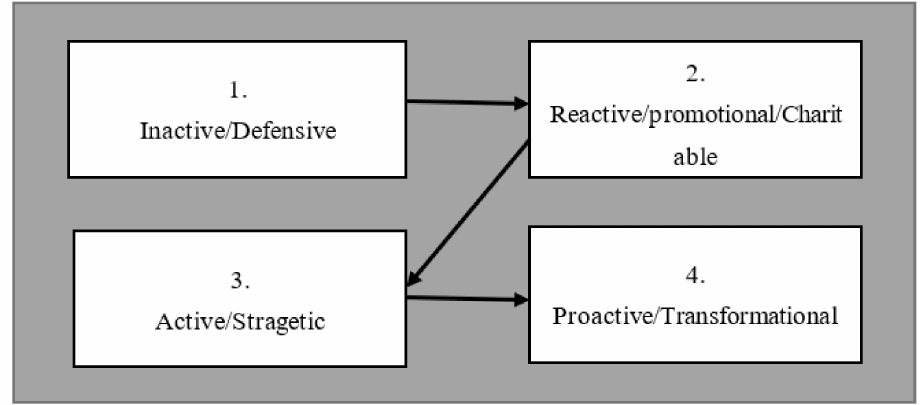
Figure 1. Key components of sustainable entrepreneurship. Adopted from